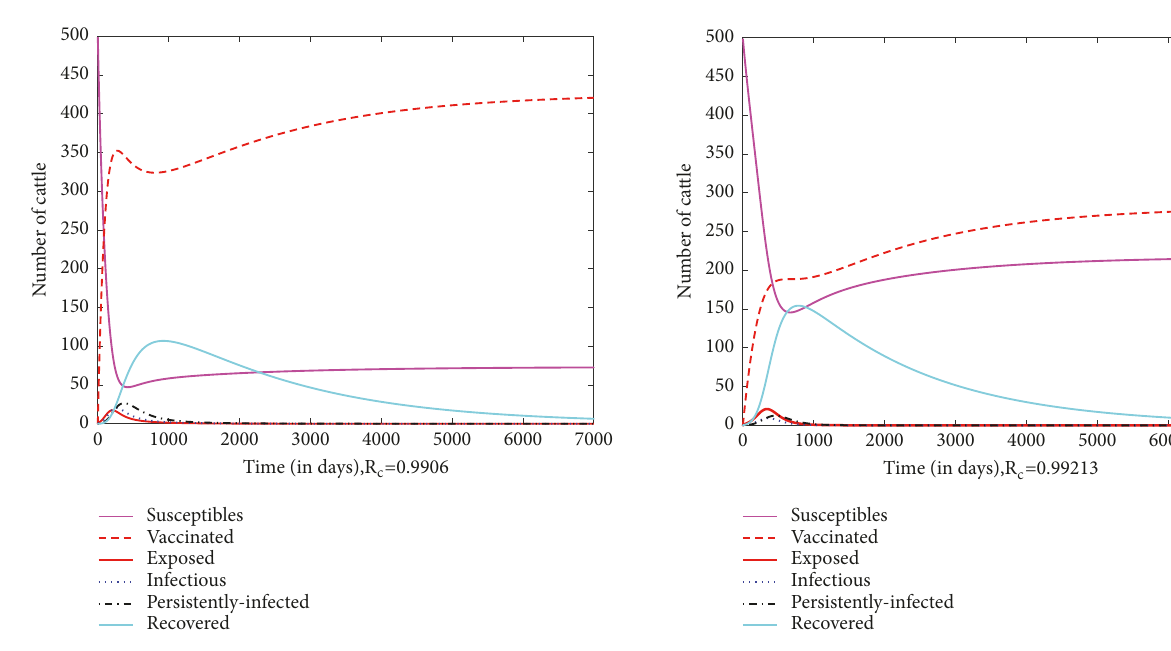
Figure 6: Number of cattle in each compartment with baseline parameter values in Table 1 with the assumption that 80 % of susceptible cattle are vaccinated within 49 days ( 𝜌 = (0.65 ∗ 0.8 ∗ 0.8)/49 ) without treating infectious cattle (𝛼 and 𝑉 0 = 𝐸 0 = 𝑄 0 = 𝑅 0 = 0 , giving approximate equilibrium values 𝑆 ∗ = 73 , 𝑉 ∗ = 421 , 𝐸 ∗ = 𝐼 ∗ = 𝑄 ∗ = 0 , 𝑅 ∗ = 6 , and R each compartment at time 𝑡 is plotted in Figure 7; in this case, = 0.99213 for parametric values in Table 1. R 𝑐